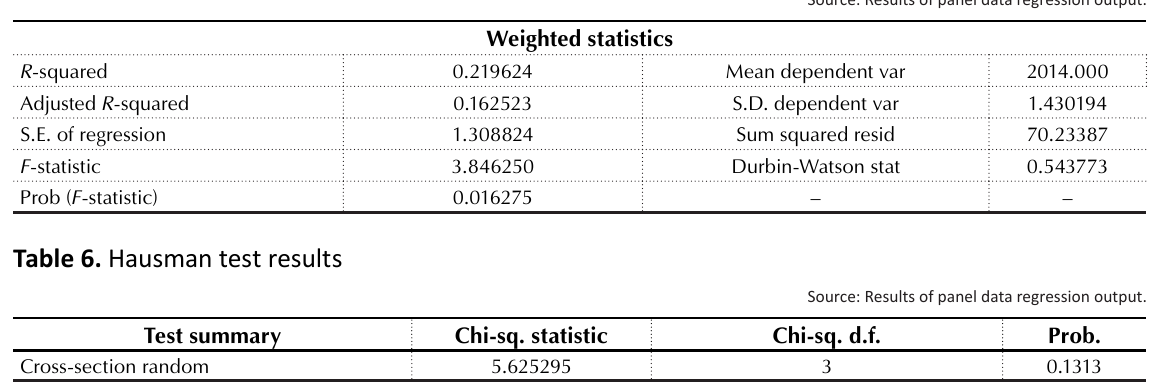
Table 5. Regression results using RE model